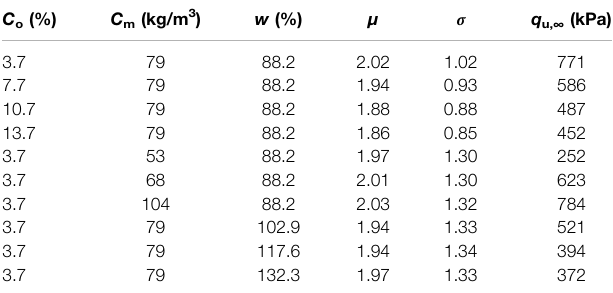
TABLE 1 | Strength q u, ∞ under different physical